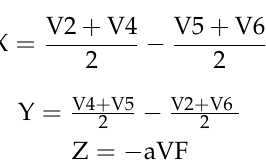
Figure 1. Electrode placement to record the 12-lead electrocardiogram. Abbreviations: LA, left arm electrode; LF, left foot electrode; RA, right arm electrode; V, precordial electrode.